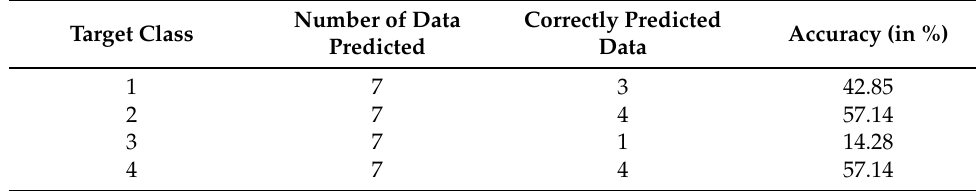
Table 6. Tested Predictions based on Pohang Earthquake